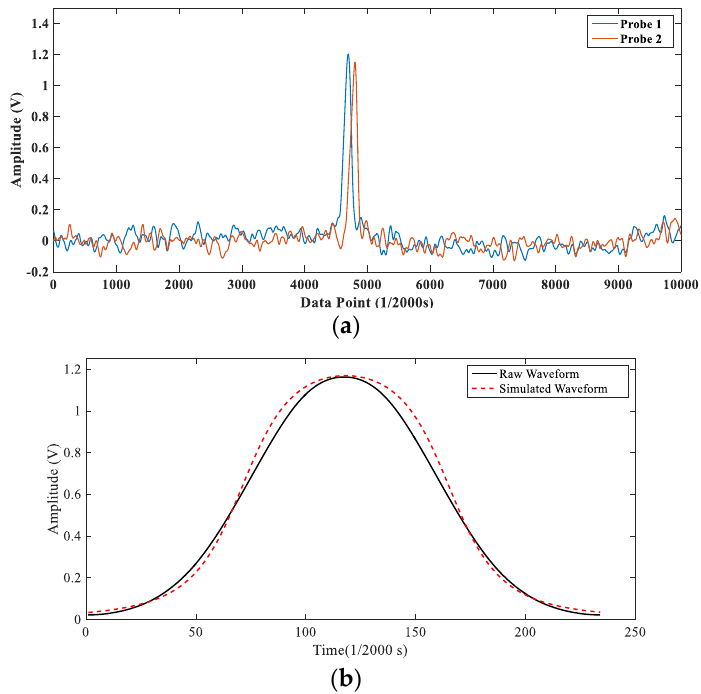
Figure 9. The raw signal with the debris characteristic pulse. ( a ) The raw data with the debris characteristic pulse; ( b ) The debris characteristic pulse.